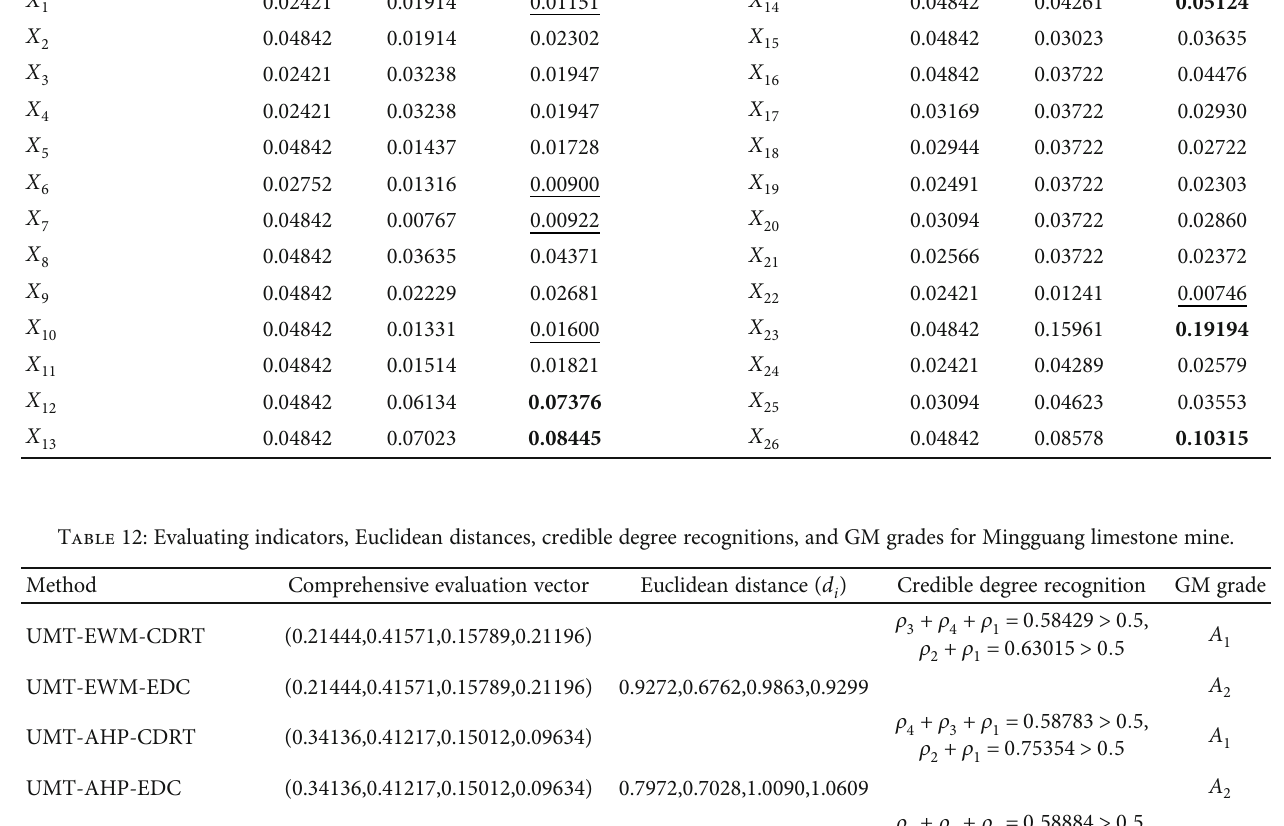
Table 11: Weights of the evaluating indicator for Mingguang limestone mine. The underlined indicates the smallest fi ve evaluating indicator weights for the EWM-AHP method. The bold values indicate the largest fi ve evaluating indicator weights in the EWM-AHP method. Evaluating